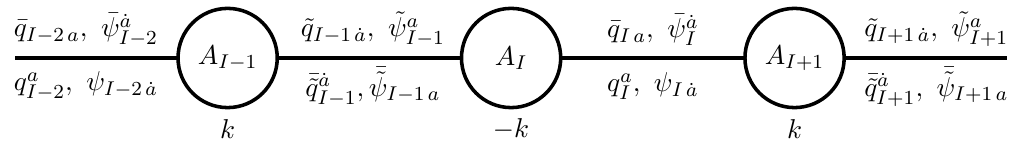
Figure 1 . The quiver and field content of the N = 4